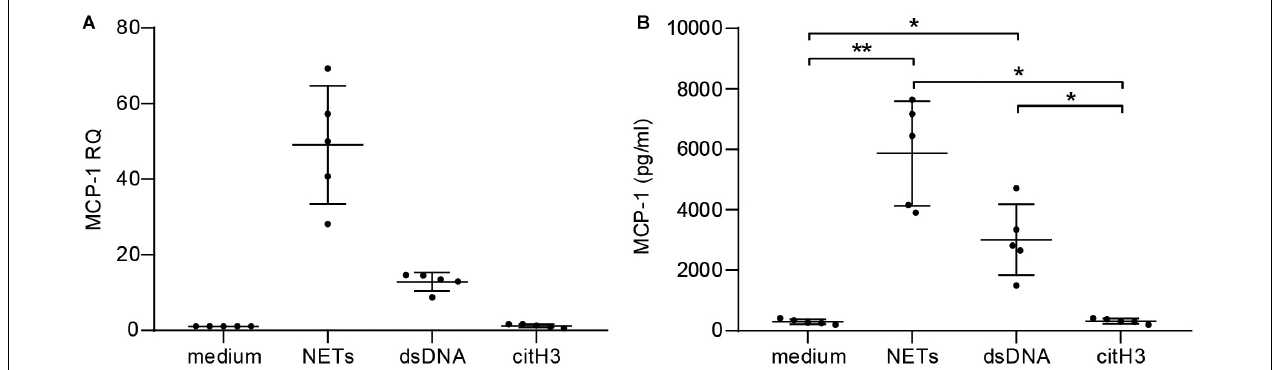
FIGURE 2 | Stimulation of human coronary artery endothelial cells with NETs. hCAECs were stimulated with isolated NETs, dsDNA, and citH3 for 6 and 24 h. MCP-1 gene expression was assessed (A) on mRNA levels by qPCR after 6 h and is presented as fold change over an unstimulated control after normalization to the mean of two endogenous controls. (B) Release of MCP-1 was measured in cell supernatants by ELISA after 24 h of stimulation. Data are presented as mean ± SD. Experiments were repeated five times and analyzed using one-way ANOVA followed by Tukey’s multiple comparisons test. * p < 0.05, ** p < 0.01.